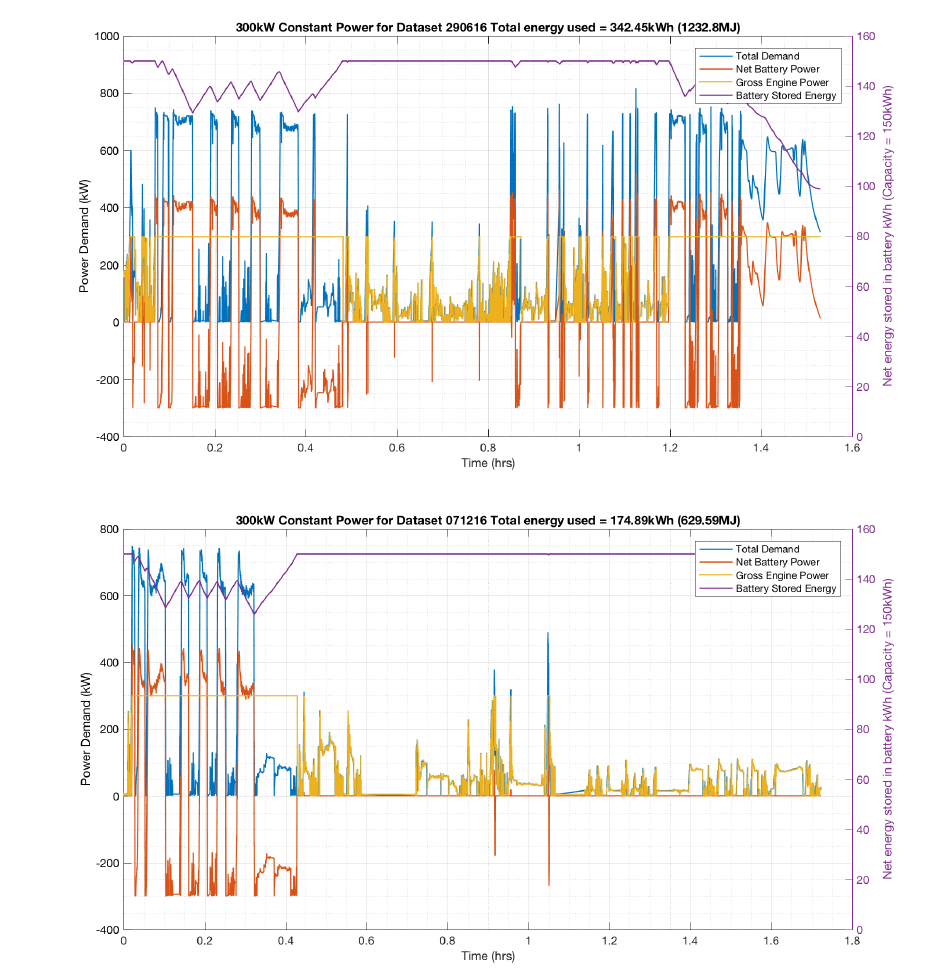
Figure 17. Simulation results for engine setpoint of 300kW and battery capacity of